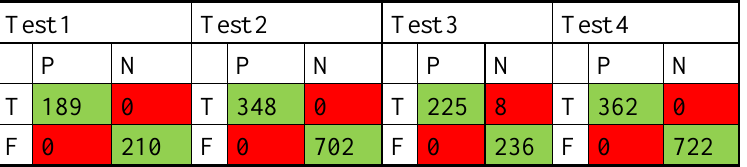
Table 8. Confusion matrix for esxtrasystoles detection for user 5.